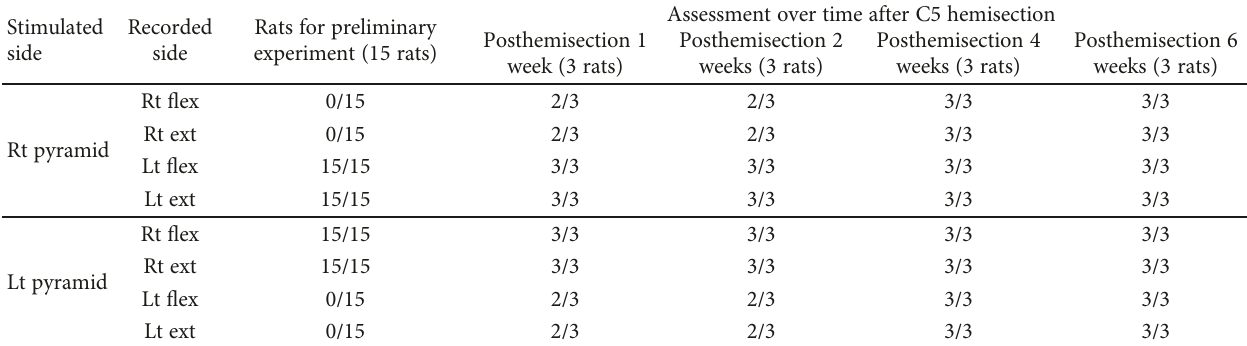
Table 1: Existence or nonexistence of CMAPs in the group of rats for preliminary experiment and the group of rats for assessment over time after C5 hemisection.